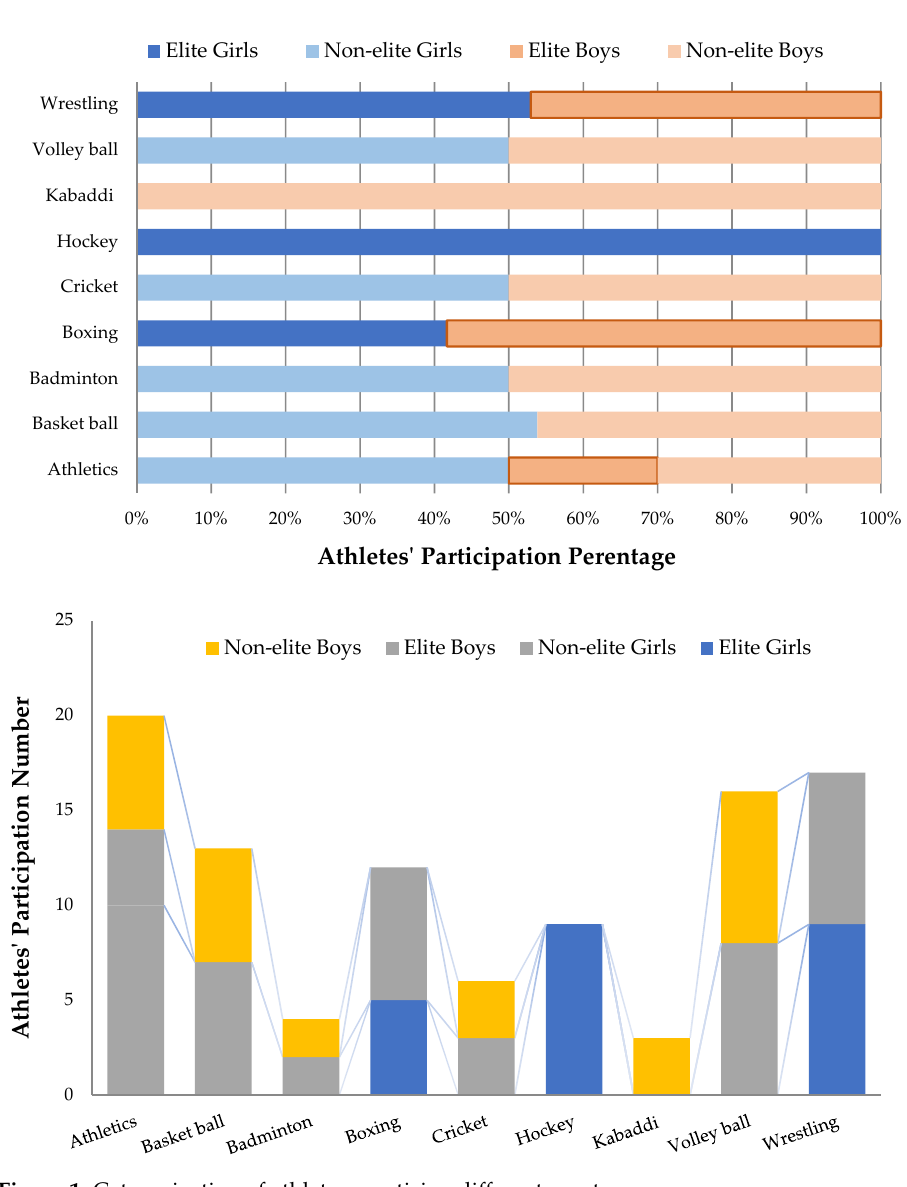
Figure 1. Categorization of athletes practicing different sports .